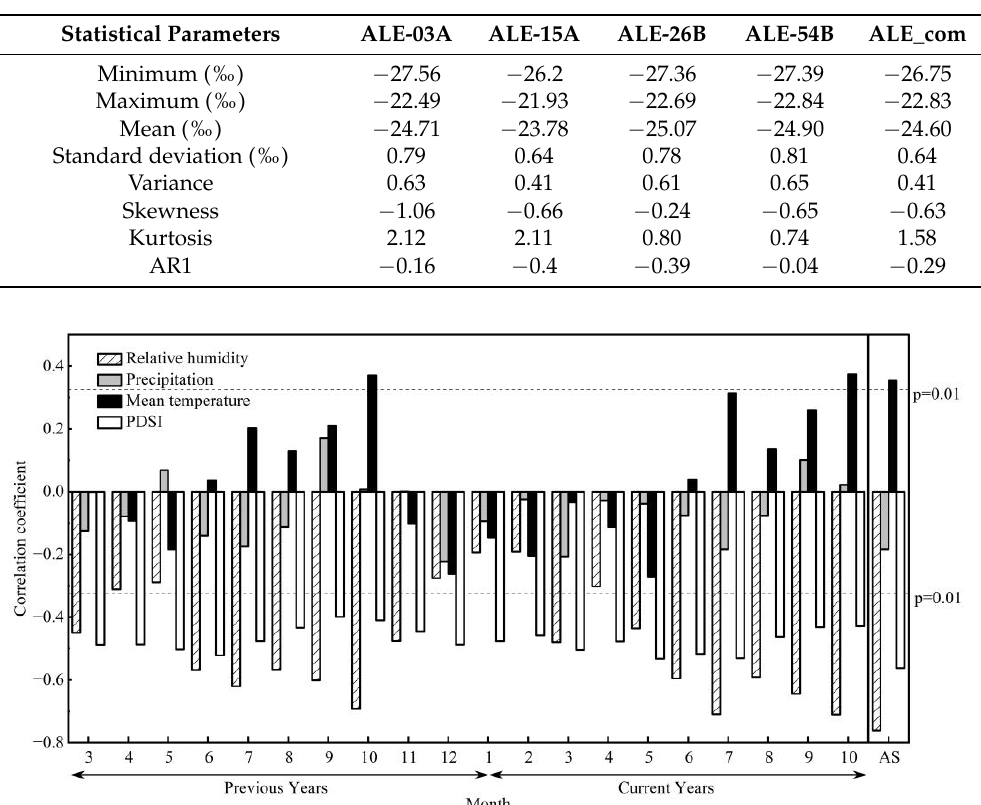
Figure 4. Correlation of tree-ring Δ 13 C series with climatic factors for 1959–2018.